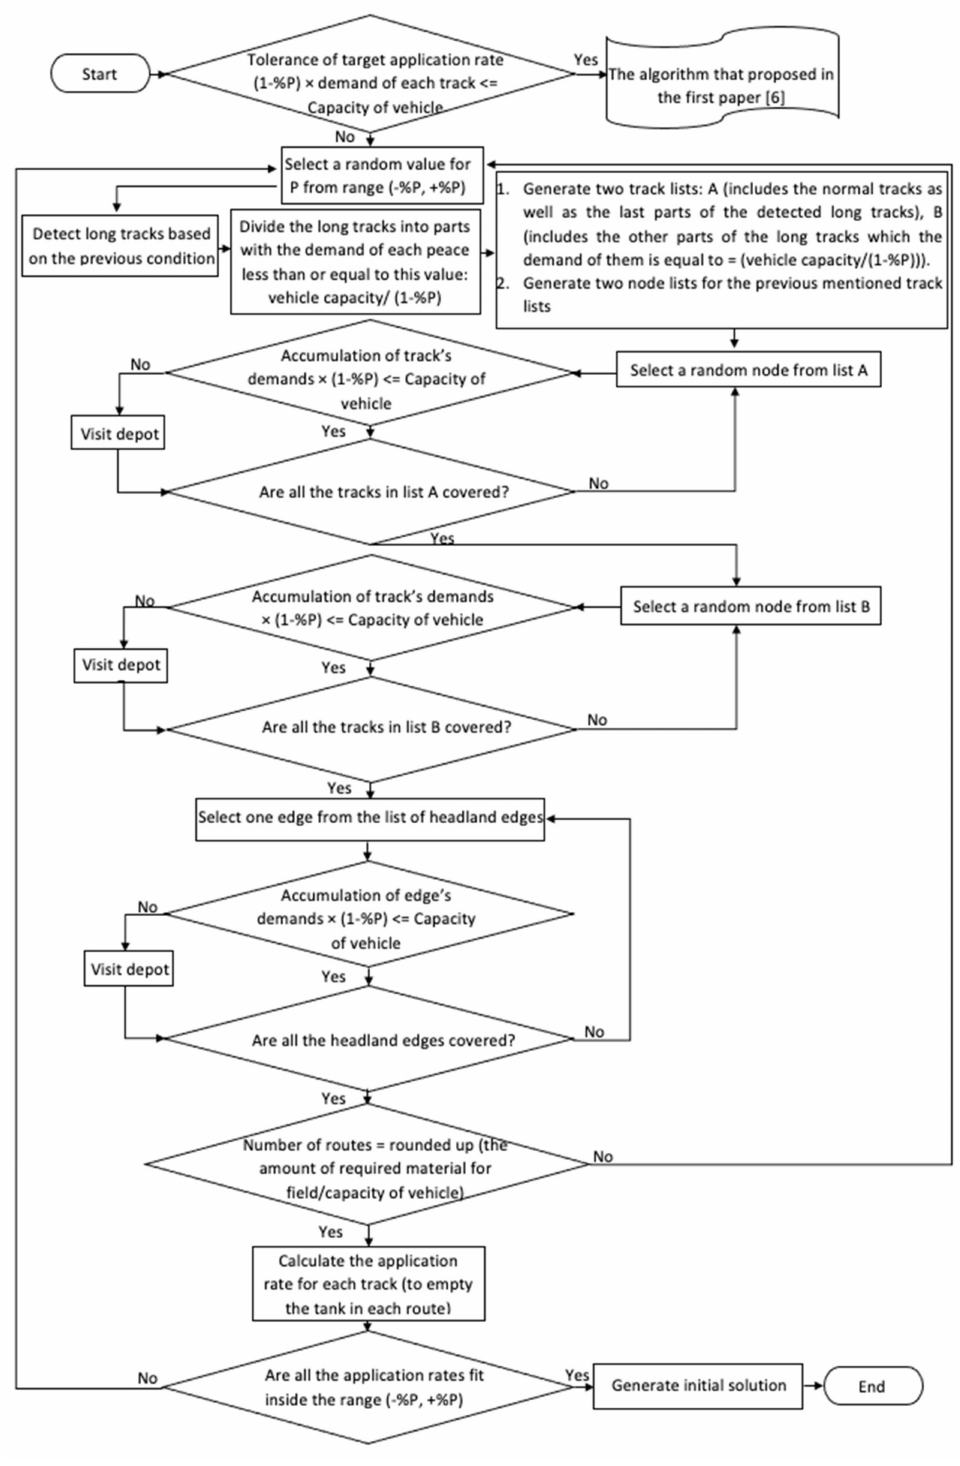
Figure 4. Overview of the process of generating an initial